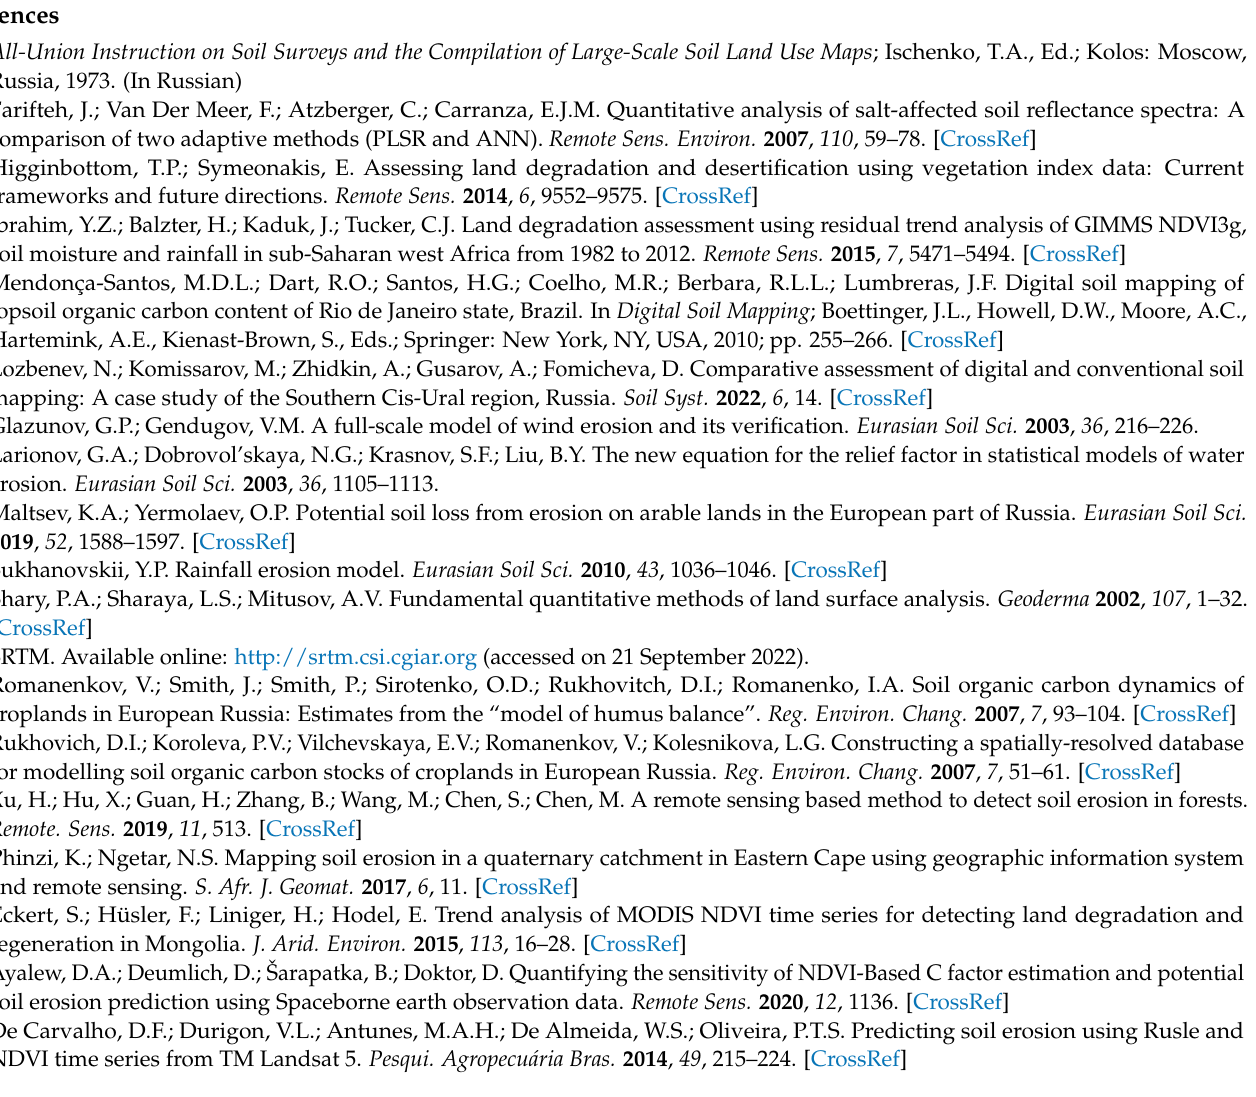
Table S20: Post hoc analysis of the means of thickness of humus horizon in NIR mean classes for soil varieties; Table S21: ANOVA of the difference between the means of BAND mean values in degraded and non-degraded soils identified in field studies; Table S22: ANOVA of the difference between the means of OM content in BAND mean classes for degraded and non-degraded soils; Table S23: ANOVA of the difference between the means of thickness of humus horizon in BAND mean classes for degraded and non-degraded